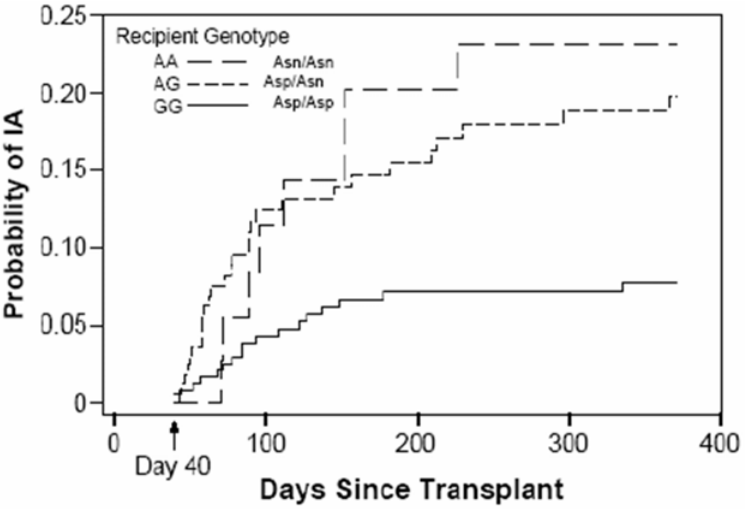
Figure 3. Kaplan-Meier curve demonstrating elevated risk of developing IA in HSCT recipients with AA or AG genotype, using GG as the reference genotype. The data represent 59 HSCT recipients who developed IA between days 40–365 following transplantation and 135 HSCT recipients who survived . 40 days following HSCT and did not develop IA (HR genotype AA 5.56, 95% CI 1.88, 16.48; HR genotype AG 3.00 95% CI 1.46, 6.14; p , 0.0005). The genotypic results are reported for follow-up beyond 40 days, using a left-censored analysis.